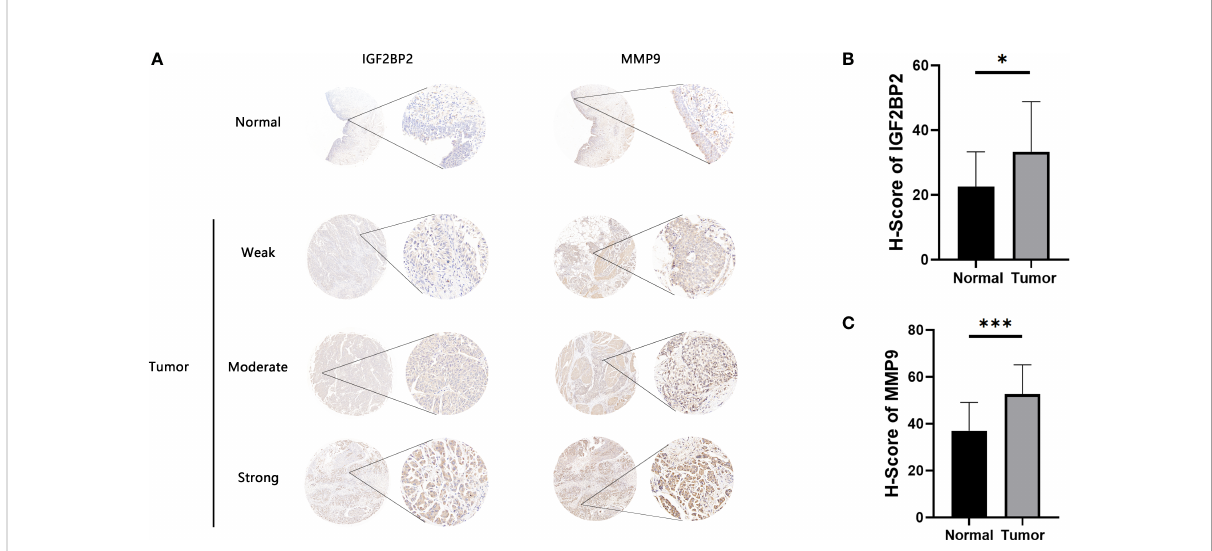
FIGURE 3 Immunohistochemical evaluation of IGF2BP2 and MMP9. (A) Weak, moderate, and strong immunohistochemical staining of IGF2BP2 shown respectively in normal and BLCA samples. (B) The H-scores of IGF2BP2 in BLCA tissues compared with normal tissues. (C) The H-scores of MMP9 in BLCA tissues compared with normal tissues. *P < 0.05, ***P <